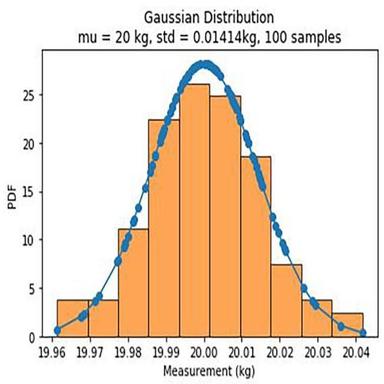
A Gaussian distribution was used to generate the weights randomly measured at any KMPs. This graph visualizes how the measured weights vary at KMPs given the mean of 20 kg and the standard deviation of 0.014 kg. The mean weights may be different from 20 kg depending on KMP locations, especially if there is a material loss before the measurement. Also, in actuality, the relative random and systematic errors may be much larger than 0.05%.